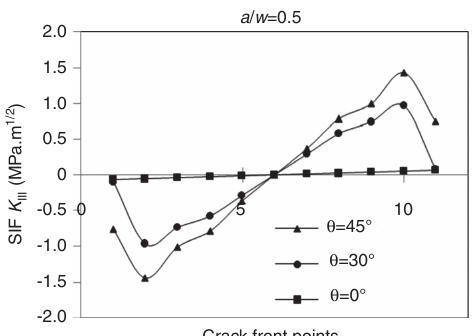
Figure 18 Effect of crack angle on K